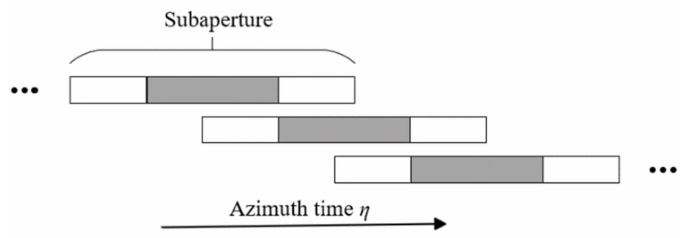
Figure 2. Dividing overlapping